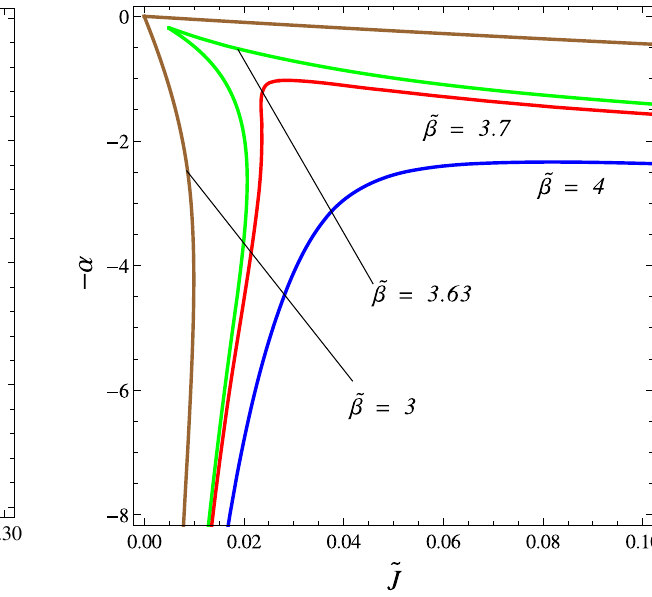
Fig. 17 Curves of the conjugate variable − α( J ) at fixed β for Kerr– AdS black holes in the canonical treatment. The stability curves of ˜ M = 0 . 3 (green), ˜ M = 0 . 4 (red) and ˜ M = 0 . 6 (blue) are plotted. There are no turning points on the diagram